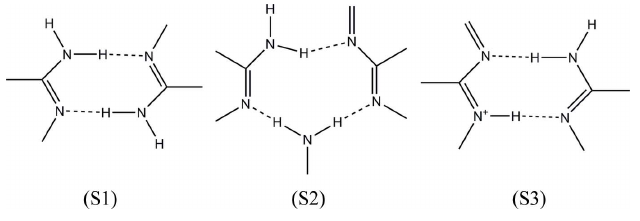
Figure 18 Supramolecular synthons observed in this